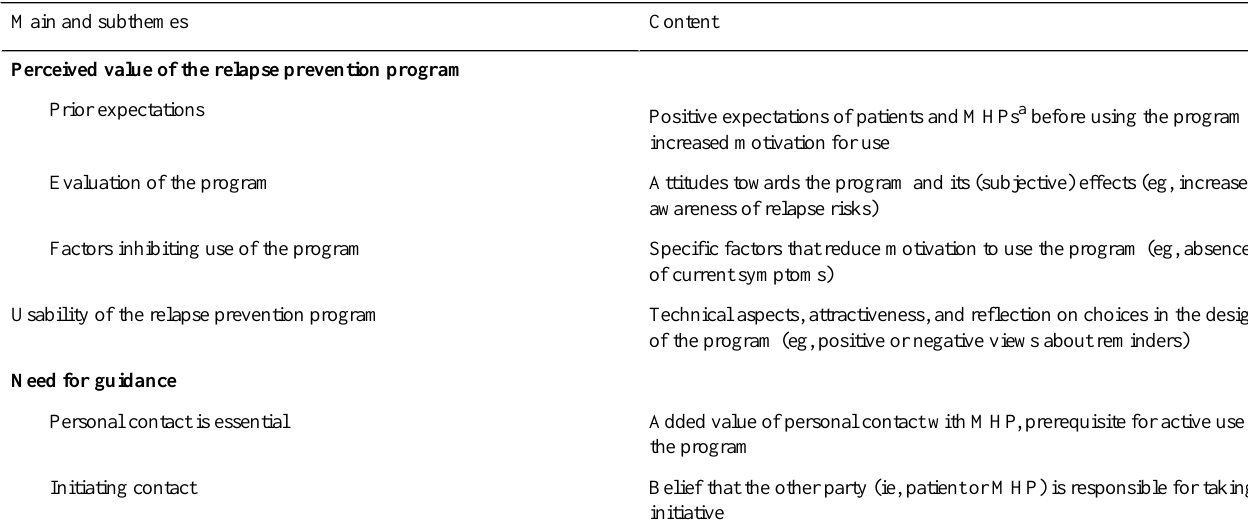
Table 2. Overview of the main themes and subthemes and a description of their